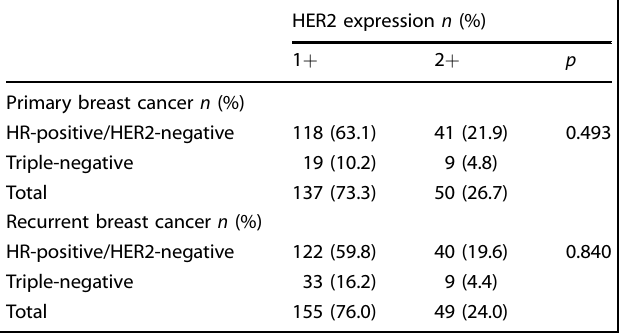
Table 3. Distribution of HER2 expression by IHC according to tumor phenotype in the HER2-low cohort.